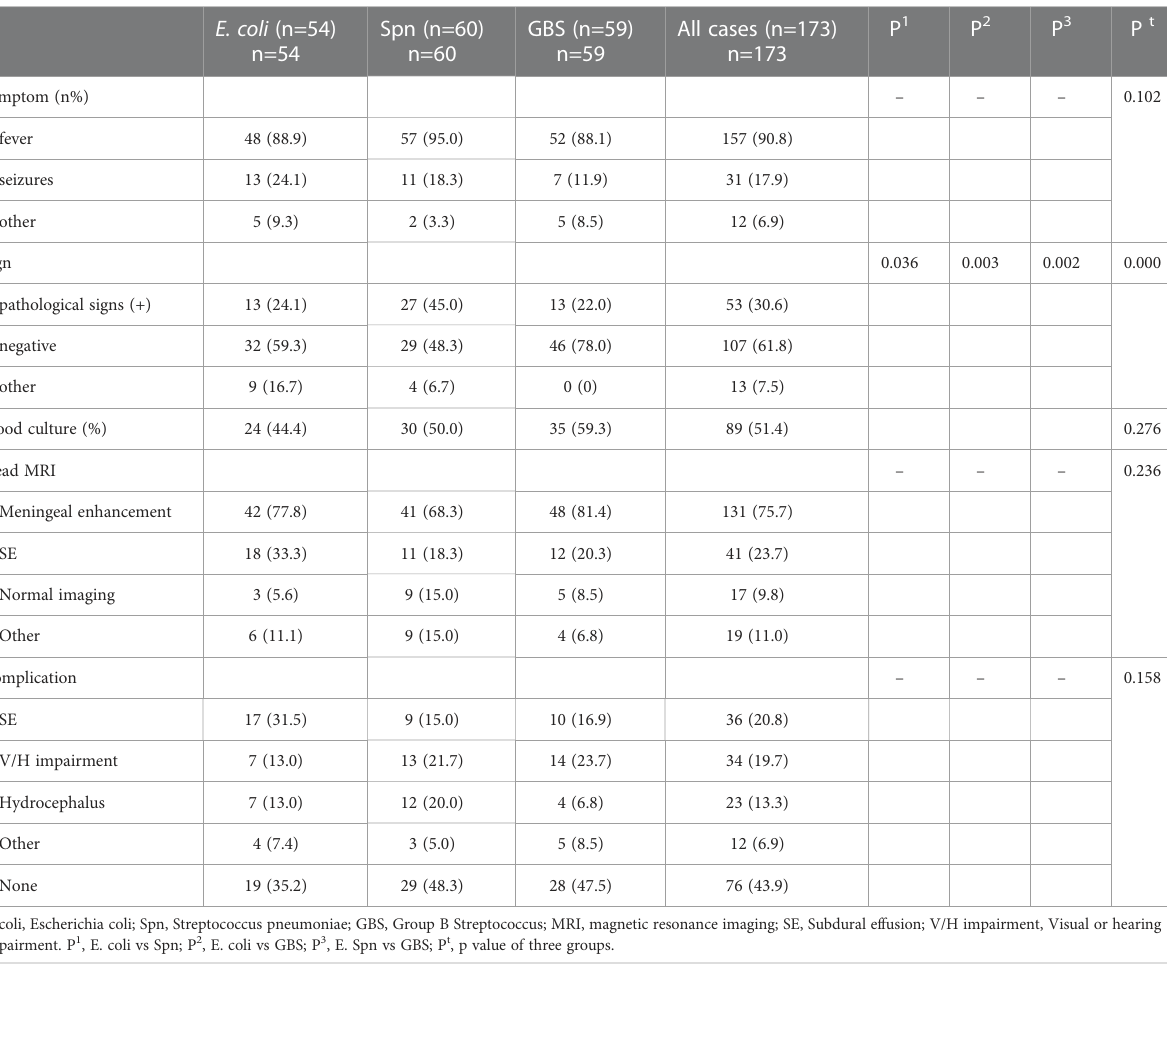
TABLE 2 Comparison of clinical features of patients diagnosed with different etiologies of bacterial meningitis.